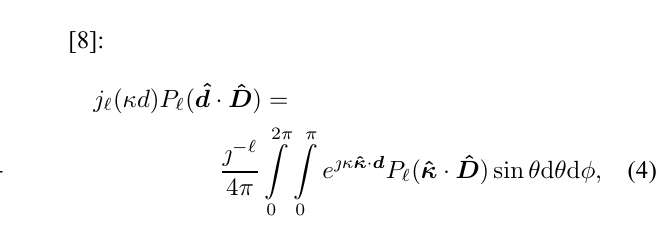
Figure 1: Two distant groups from which the factorization in Eq. (1) holds. The square with center at b is the source group. The square with center at a is the test